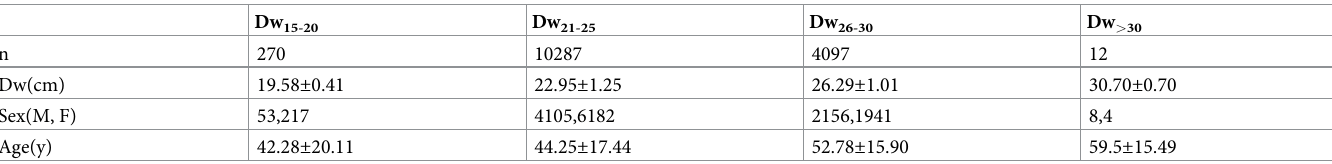
Table 2. Patient